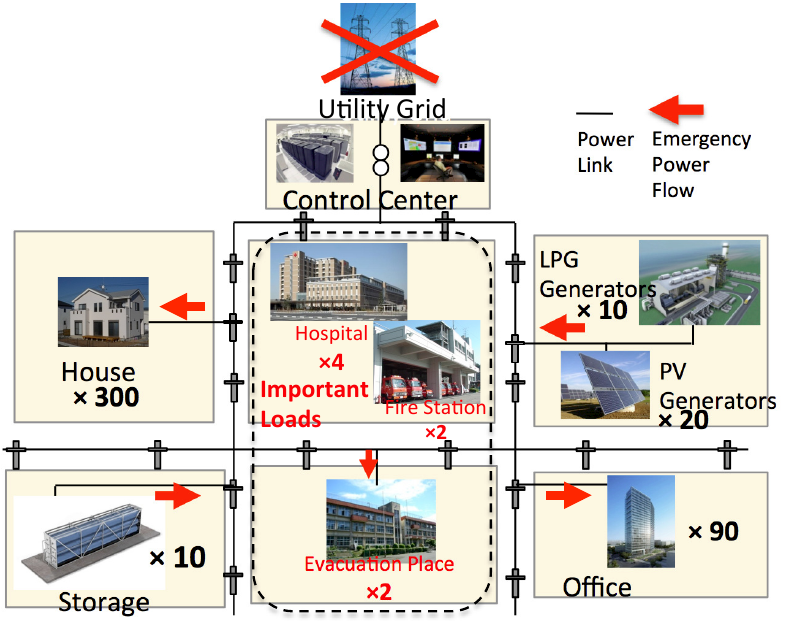
Figure 12. Overview of the simulated large-scale microgrid.